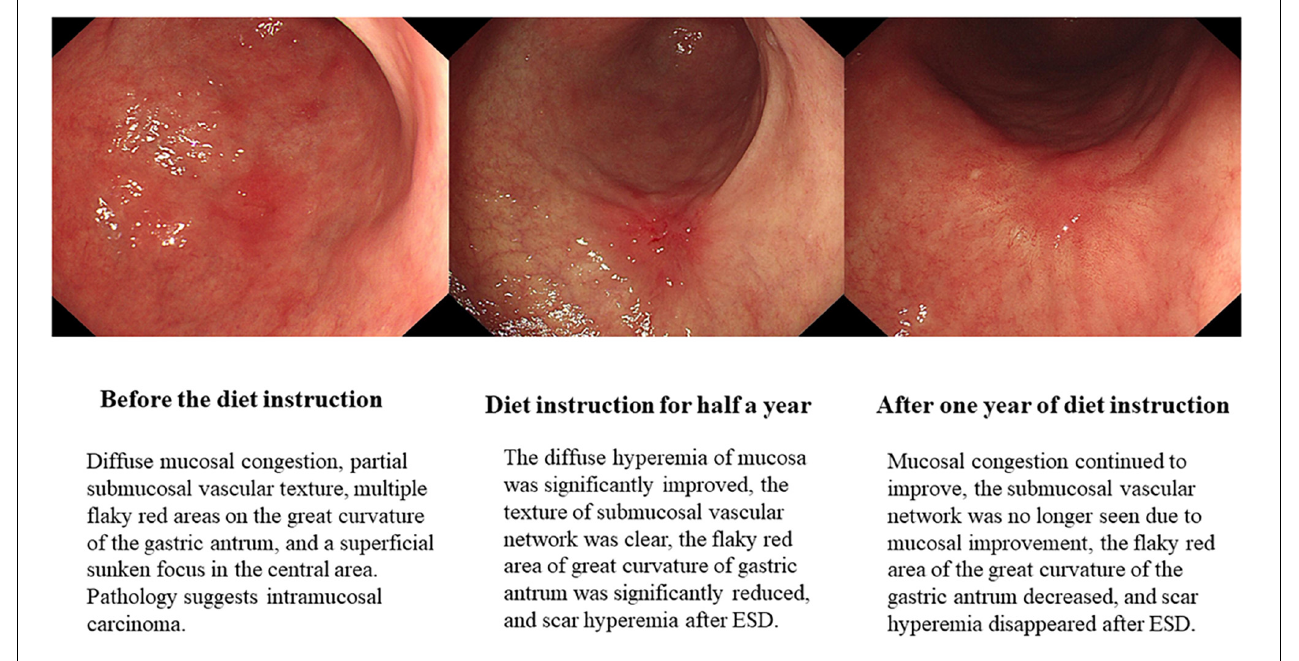
FIGURE 3 | Changes of gastric mucosa in patients with early gastric cancer before and after dietary guidance.